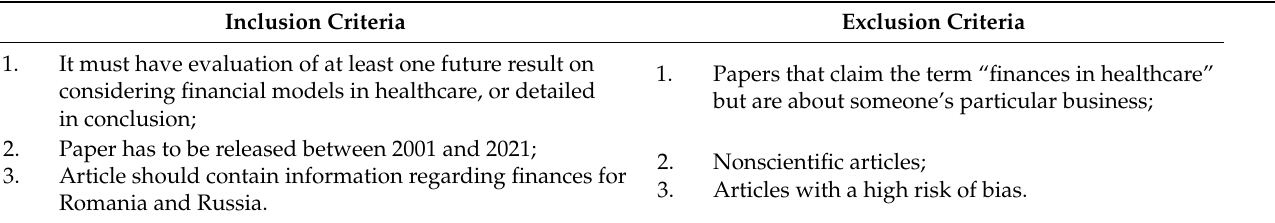
Table 1. Inclusion and exclusion